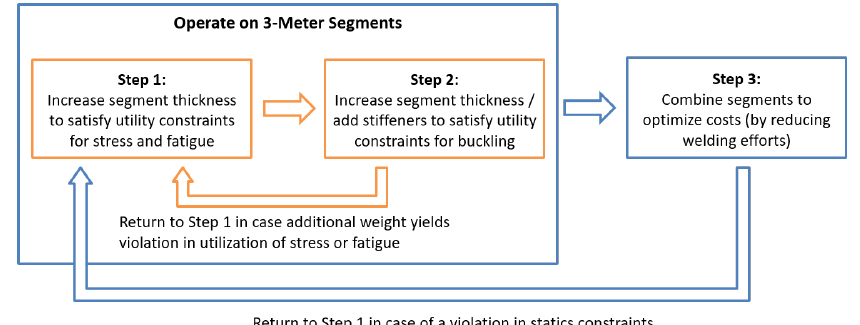
Figure 5. Three-step heuristic optimization